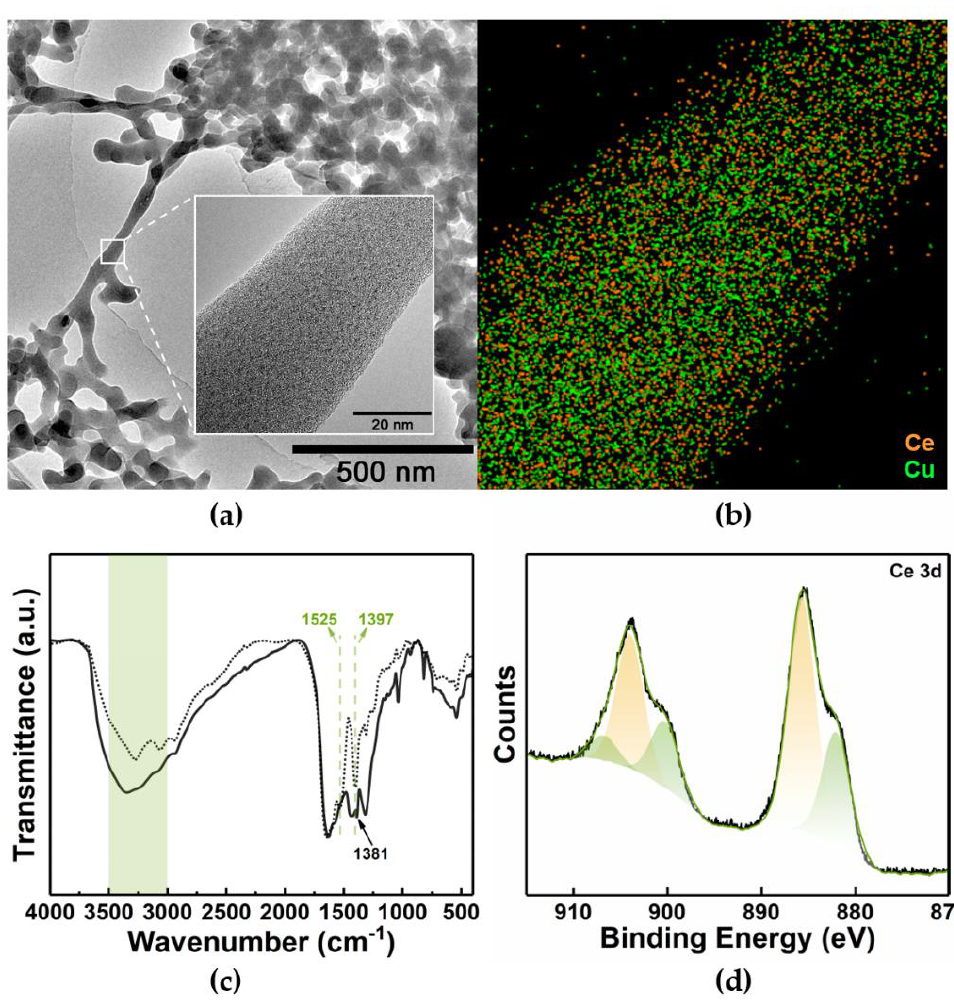
Figure 3. ( a ) TEM image of Ce-Cu NCs aggregates; ( b ) EDS elemental mapping of Cu and Ce in Ce-Cu NCs aggregates; ( c ) FTIR spectra of Cu NCs (dotted line) and Ce-Cu NCs aggregates (solid line); ( d ) XPS spectrum of Ce 3d electrons in Ce-Cu NCs aggregates. Inset in ( b ) shows zoomed-in detail of Ce-Cu NCs aggregates TEM image.